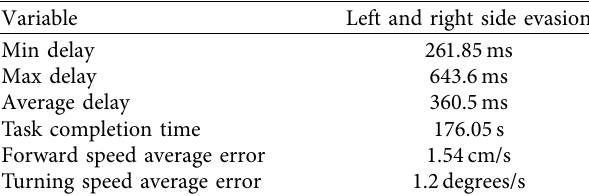
Table 2: Average data